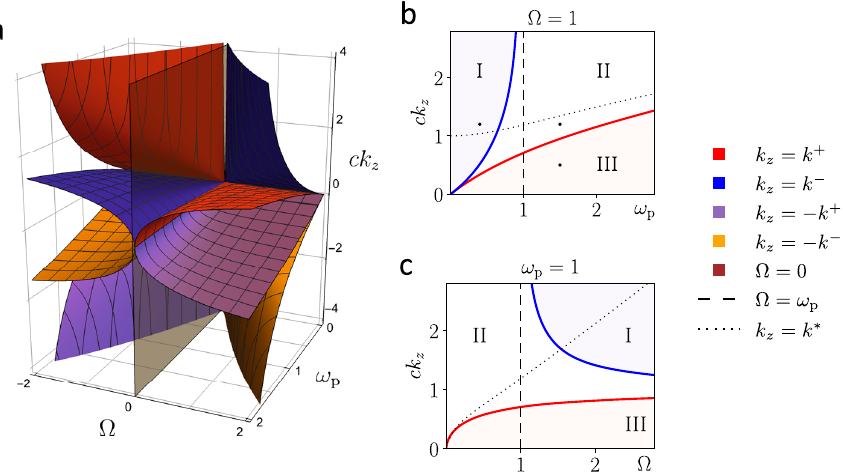
Fig. 2 Topological phase diagrams of magnetized cold plasma. a 3D phase diagram of a cold plasma in the ( ω p , Ω , k z ) space. There are 10 topological phases. b , c 2D cross sections of ( a ) at ω p = 1 and Ω = 1. Only the k z > 0 and Ω > 0 part is shown. Dashed lines indicates Ω = ω p . Dotted lines indicates k z = k * . The Roman numerals I-III indicate three different topological phases in each cross section. The band structures and Chern numbers at three black dots in ( b ) are shown in Fig.